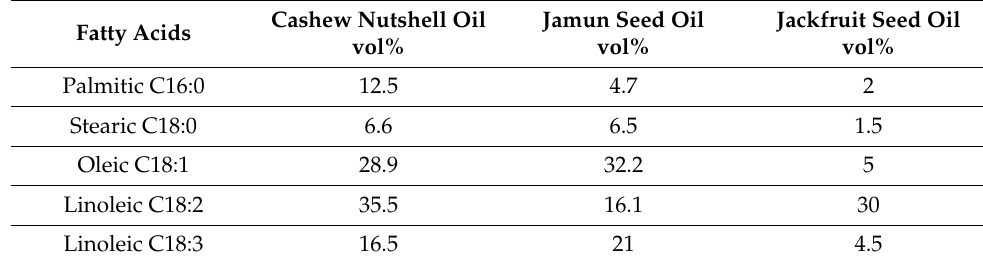
Table 2. Fatty acid compositions of biodiesel [42].